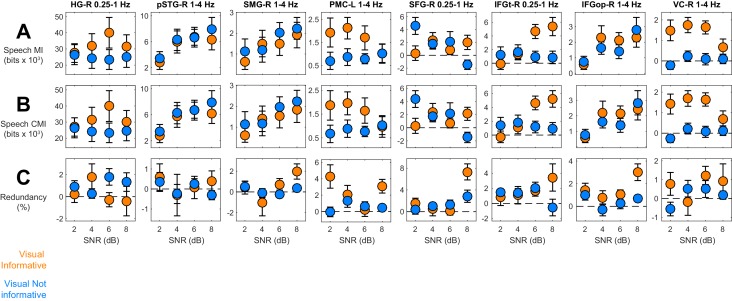
Information theoretic decomposition of speech entrainment.The figure shows condition-specific information terms for the relevant ROIs / bands (c.f. Figure 3E). (A) Speech MI. (B) Conditional mutual information, CMI(MEG;Speech), factoring out common influences between speech and lip signals. (C) Information theoretic redundancy between speech and lip MI. error-bars = ± SEM. See also Table 2. Deposited data: ID_meg; ID_speech; ID_lip; ID_infoterms.